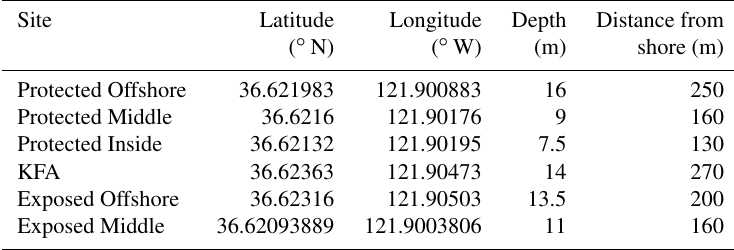
Table 1. Study site characteristics. Distance from shore measured from the closest perpendicular